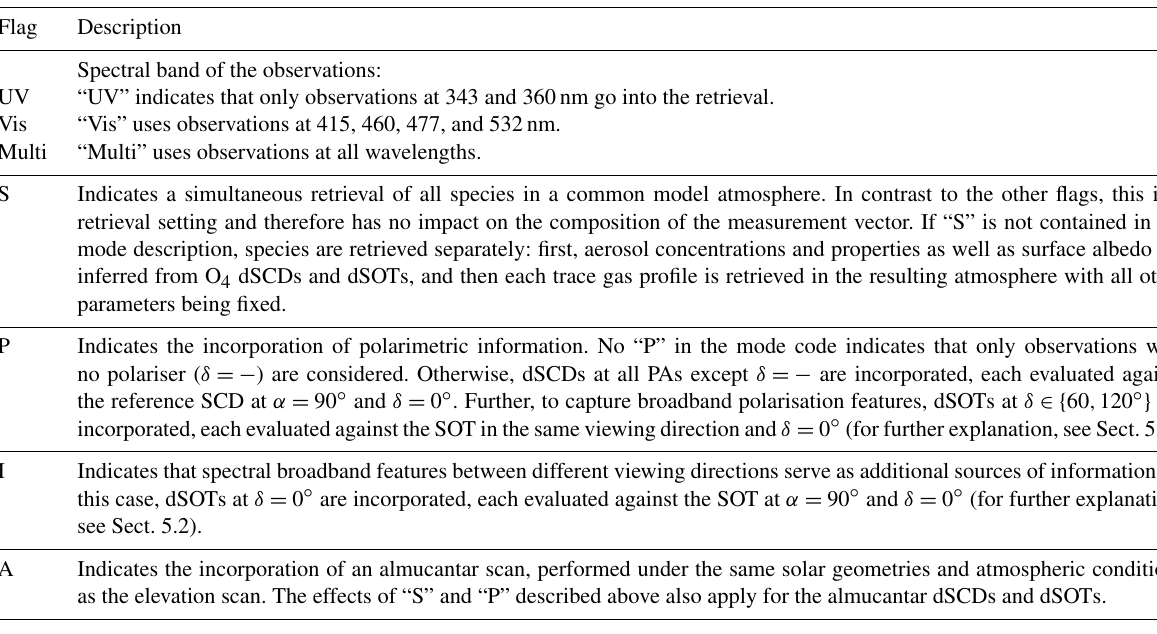
Table 6. DOFS achieved with different measurement modes (table rows) for individual state vector elements (table columns) averaged over the simulated atmospheric scenarios, namely all combinations of aerosol profiles, trace gas profiles, SZAs, and RAAs. The final row lists the total parameter numbers and hence the maximum possible DOFS